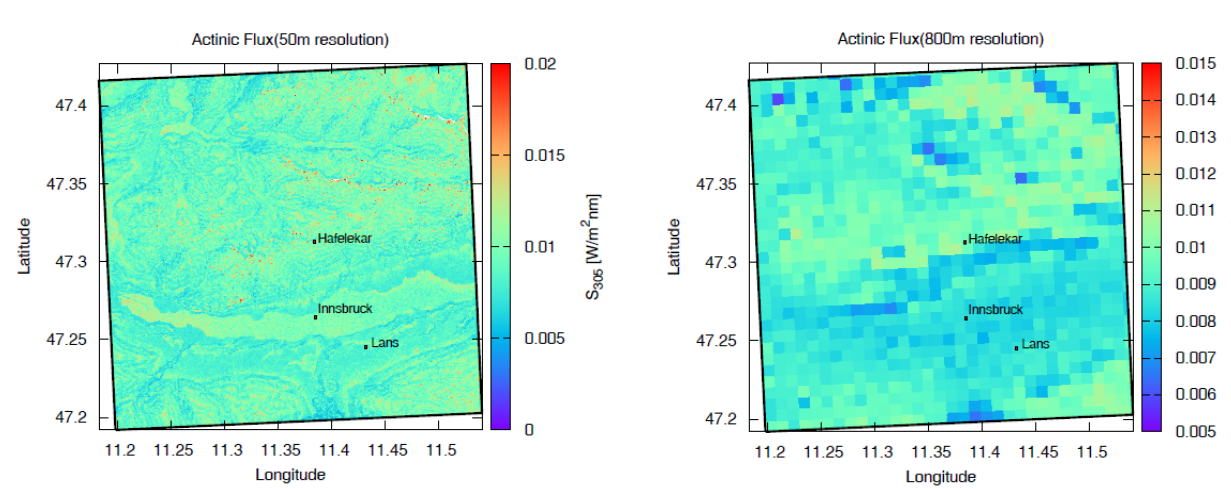
Fig. 8. 3-D radiative transfer simulation of the 305nm actinic flux Figure 8: 3-D radiative transfer simulation of the 305 nm actinic flux on 24 th February 2008 on 24 February 2008 08:20UTC (70 degree solar zenith angle) us- 8:20 UTC (70 degree solar zenith angle) using a DEM with 800 m resolution for the ing a DEM with 800m resolution for the Innsbruck area. Innsbruck area.